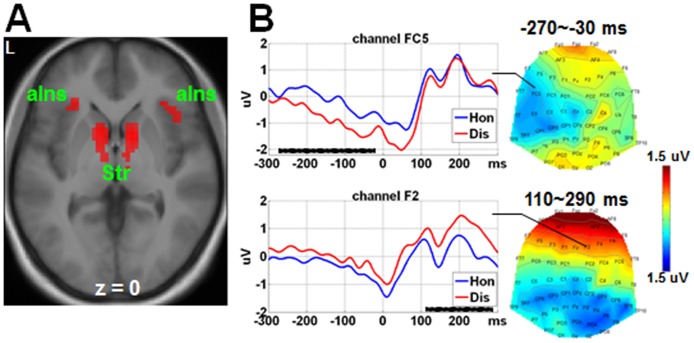
fMRI and ERP findings for the main effect of Choice.Dishonest (Dis) versus honest (Hon) choices elicited (A) stronger activations in bilateral striatum (Str) and anterior insula (aIns) (p < 0.05 FWE correction, cluster ≥ 20 voxels), and (B) more negative-going amplitudes within -270~-30 ms in the left frontal-central sites (close to FC5), and more positive-going amplitudes within 110~290 ms in the right frontal sites (close to F2). The SPM T map (for fMRI data) and the scalp topography (for ERP data) represented the contrast of (Dis-Hon). The waveforms in the representative channel are shown for the ERP findings. The horizontal black bars represent the time windows detecting statistical significance. Here, 0 ms indicates the time point of response. L = left.